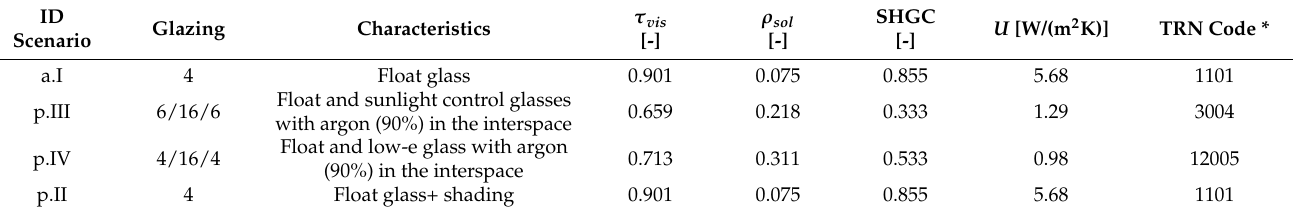
Table 4. Glazing system properties (from TRNBuild database